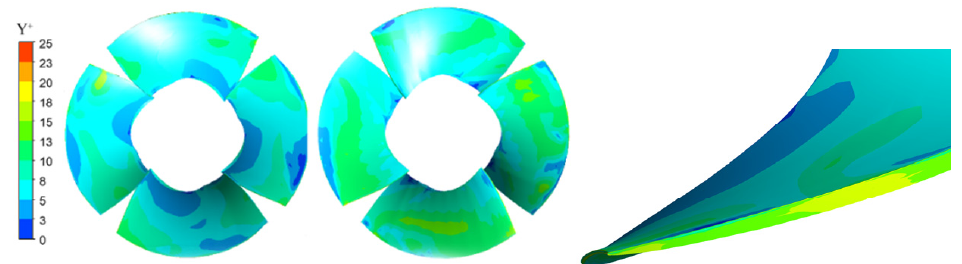
Figure 4. Impeller, guide vane and blade tip clearance grid.